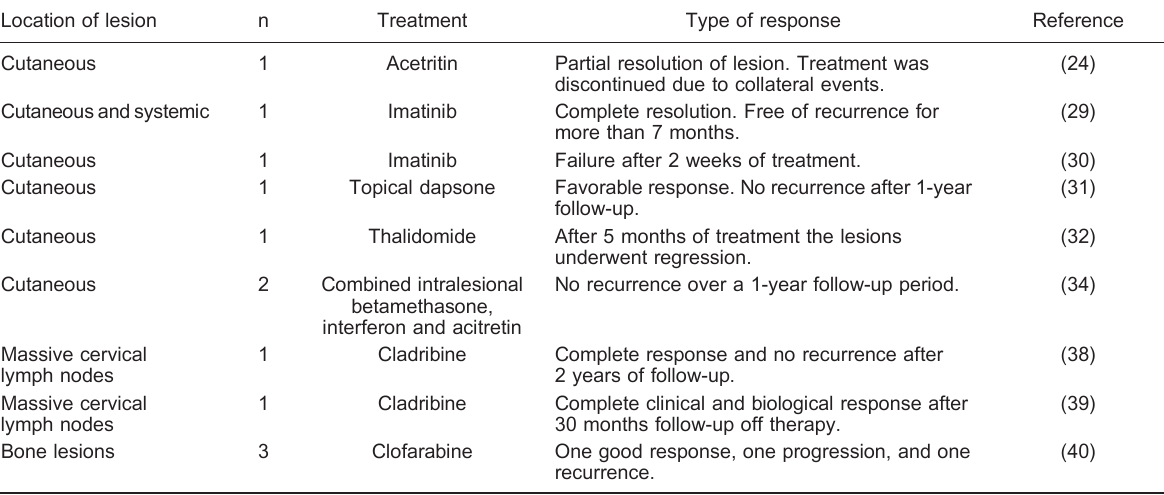
Table 2. Responses for unusual treatment in Rosai-Dorfman disease patients. Location of